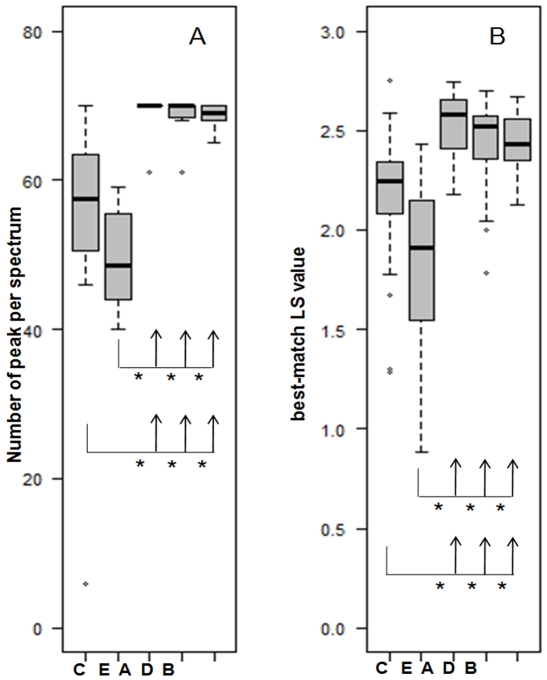
Comparison of the quality of spectra obtained from the 5 different extraction procedures.(A) Box-and-whisker diagrams of the number of peaks per spectra of the 5 procedures. (B) Box-and-whisker diagrams of the best-match LS value of the 5 procedures. The bottom and top of the box are the lower and upper quartiles, respectively; the band near the middle of the box represents the median; and the ends of the whiskers represent the lowest datum still within 1.5 interquartile range (IQR) of the lower quartile and the highest datum still within 1.5 IQR of the upper quartile. Asterisks indicate which pairs of procedures were statistically different (Wilcoxon tests, p<10−3). Procedures A, B, and D displayed significantly more peaks (p<10−4) and higher best-match LS values (p<10−3) than procedures C and E. No statistically significantly difference was found between procedure C and E on the one han and between procedures A, B, D on the other hand.